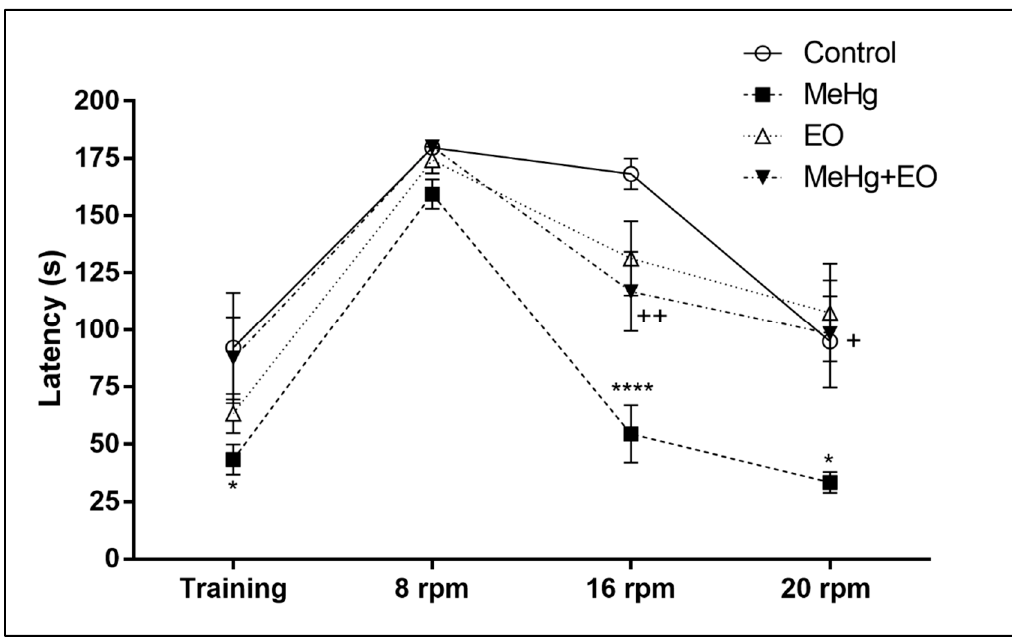
Figure 4. Euterpe oleracea consumption significantly reduces the altered motor coordination in rotarod test. Mice treated with clarified E. oleracea juice (EO) once a day for 8 days and/or methylmercury (MeHg) for 4 days showed different responses in the latencies to the first fall in the training phase and the trial phases. Data are presented as mean ± SEM ( n = 8–10). **** P < 0.0001 * P < 0.05 vs control; ++ P < 0.01 and + P < 0.05 vs MeHg group.